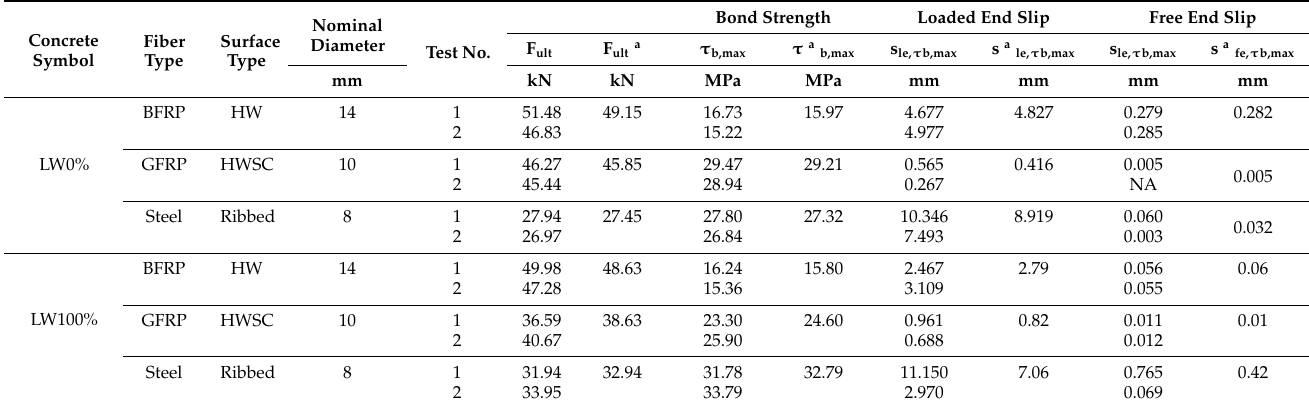
Table 5. P-O test results of different reinforcement